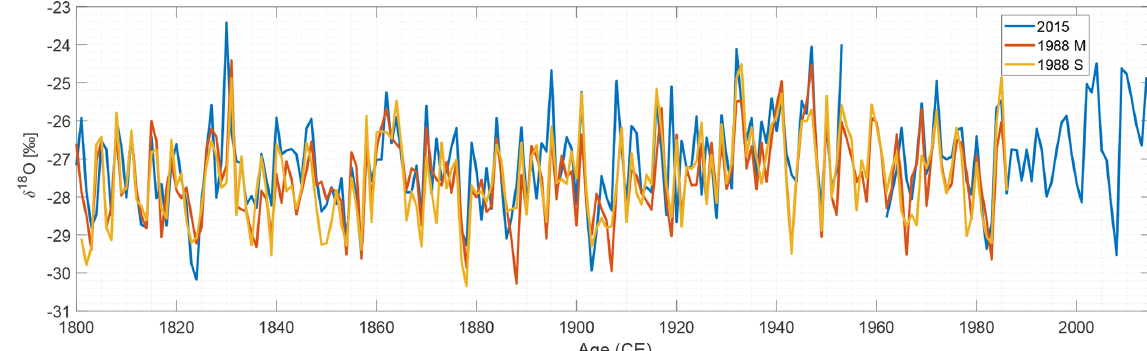
Figure 2. Annually averaged δ 18 O for the RECAP 2015 (blue), 1988 M (red) and 1988 S (yellow) cores with age.